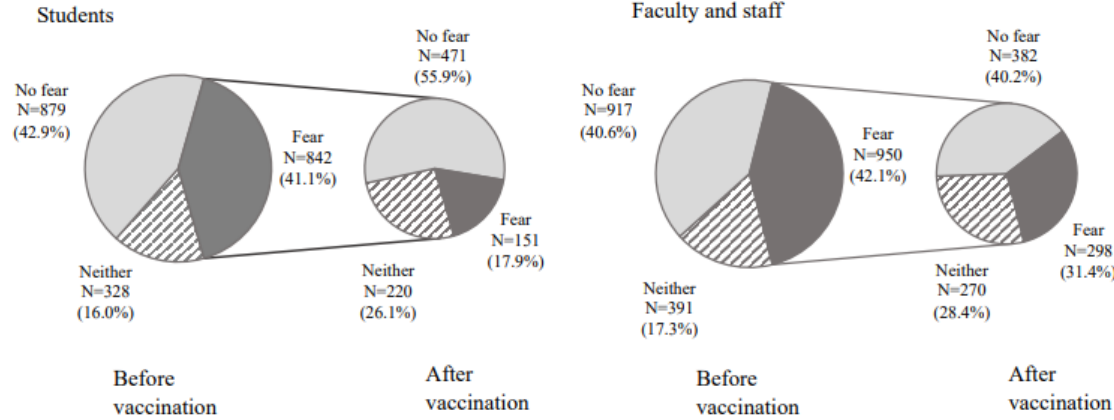
Figure 2. Fear of vaccine before and after vaccination.